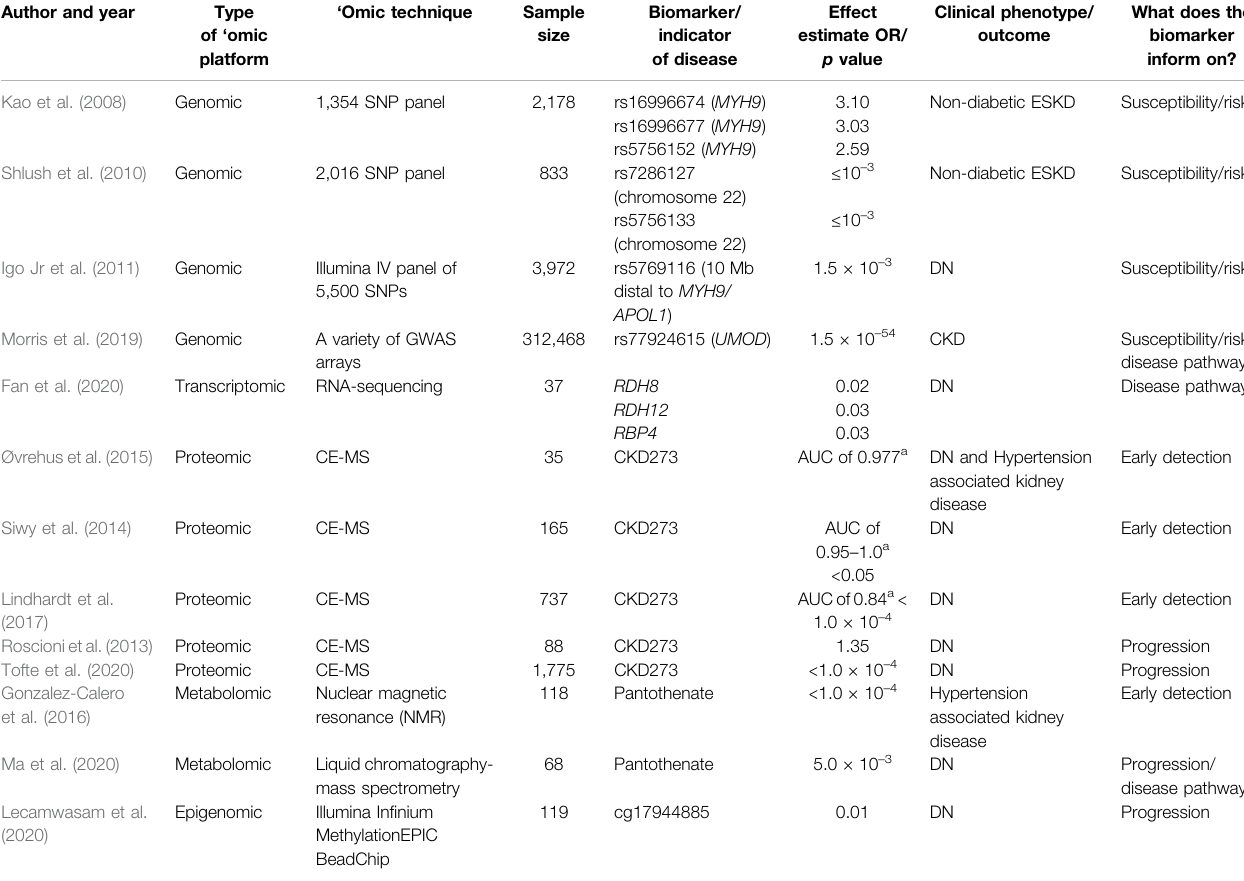
TABLE 4 | Studies that identi fi ed biomarkers/indicators for early detection of CKD, prediction of CKD progression, and disease